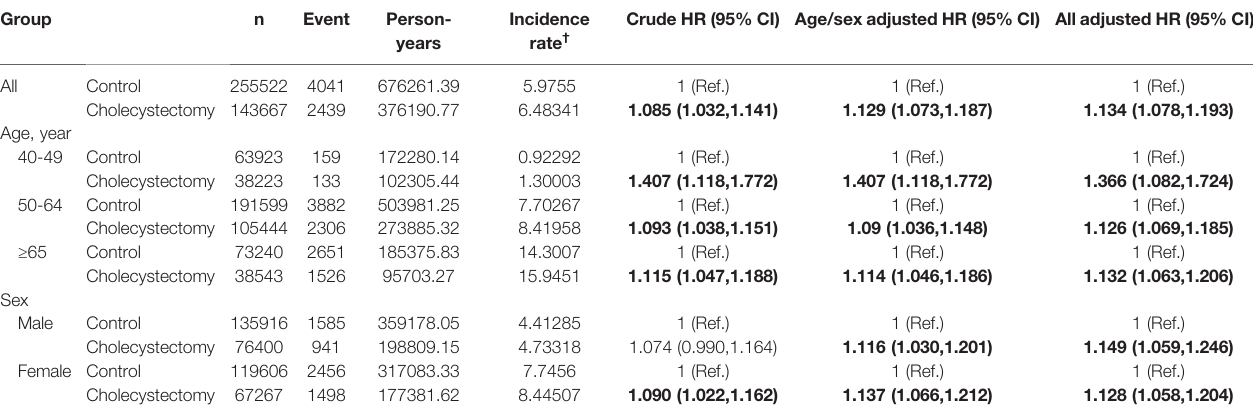
TABLE 4 | Incidence of vertebral fracture in cholecystectomy group and control group according to age and sex subgroups. Group n Event Person- years